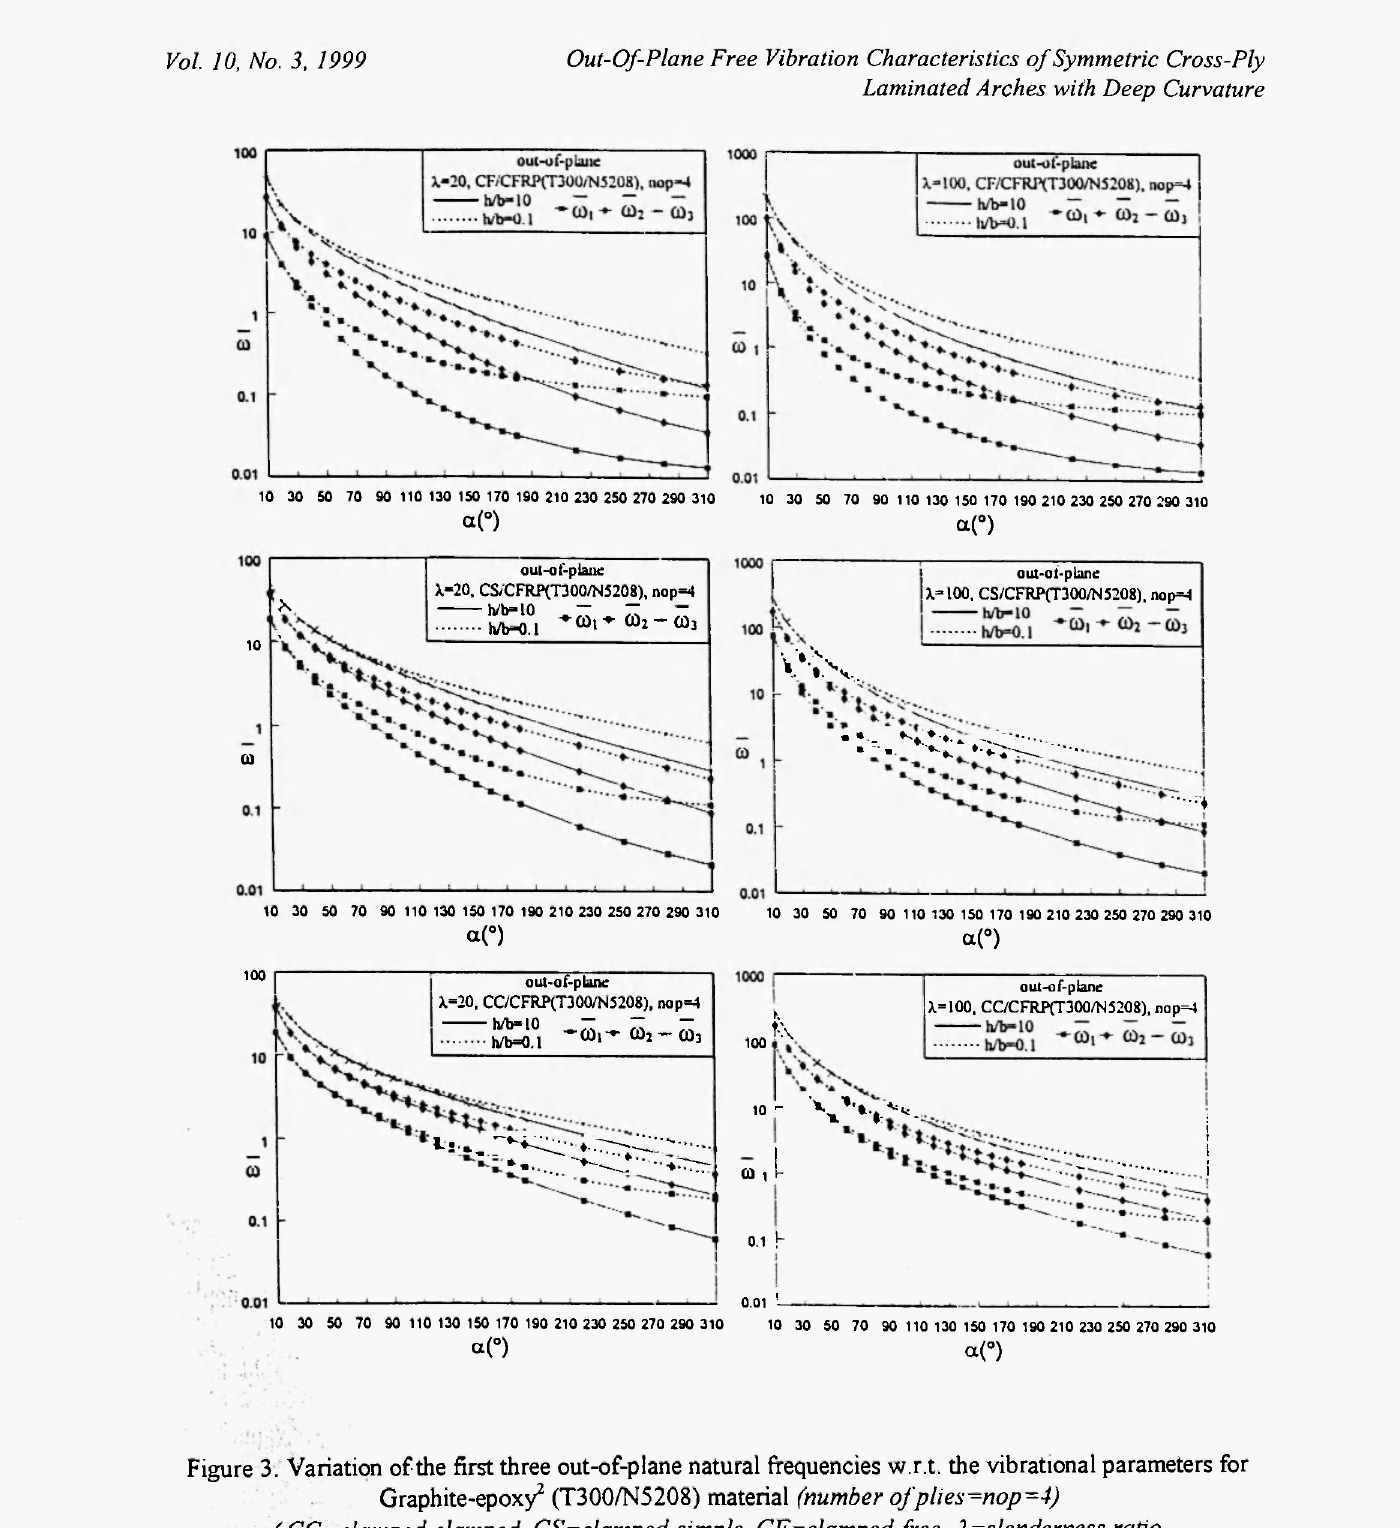
Figure 3. Variation of the first three out-of-plane natural frequencies w.r.t. the vibrational parameters for Graphite-epoxy 2 (T300/N5208) material (number ofplies=nop=4) (CC=clamped-clamped.